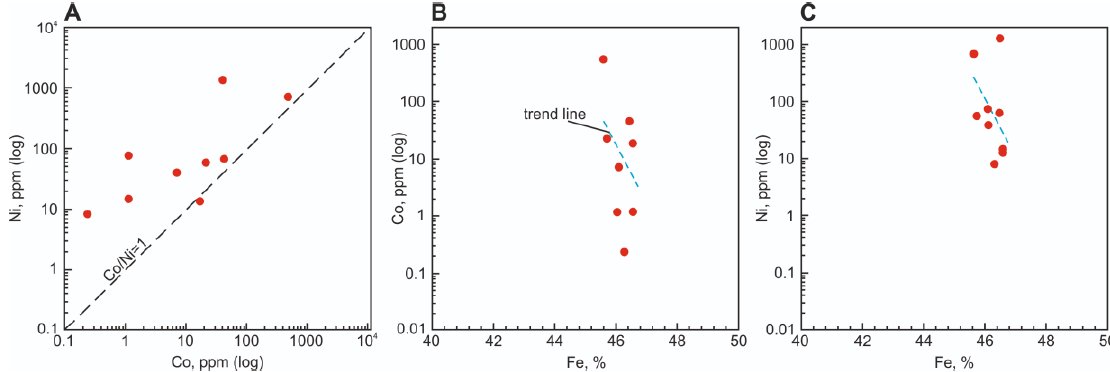
Figure 15. Ratio diagrams of ( A ) Co/Ni, ( B ) Fe/Co, and ( C ) Fe/Ni for Ру